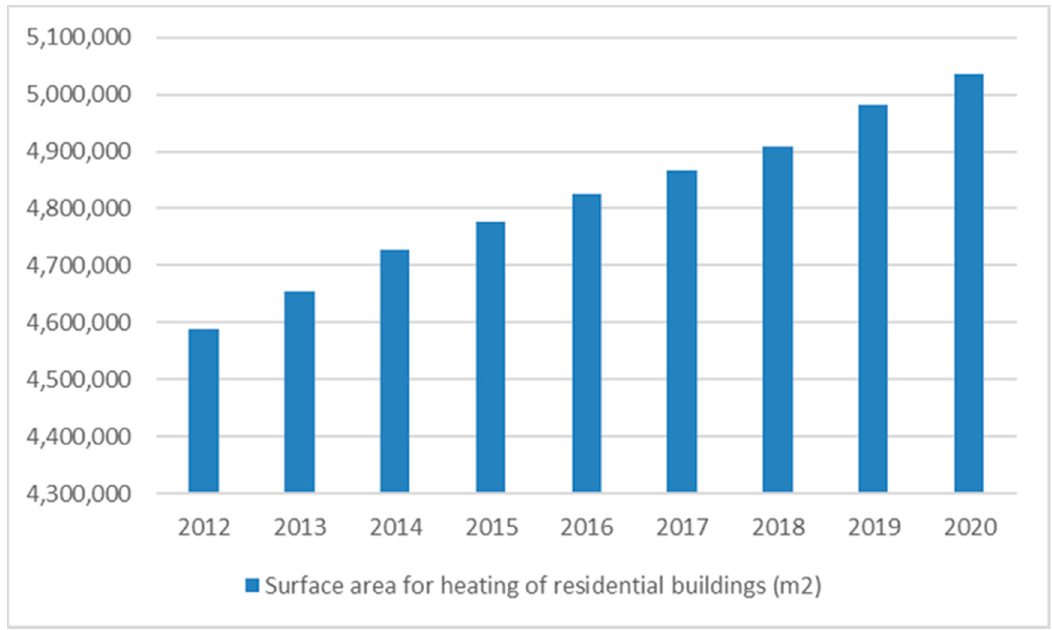
Figure 2. Increase of surface area for heating of residential buildings over the period from 2012 to 2020. From 2012 to 2020, the total residential building surface area for heating connected to the DHS was 447,090 m 2 [38]. The annual growth of the surface area connected to the DHS represents the average European growth of 1%. However, when we look at the annual percentage share of the increase in the surface area for heating since 2014, a decline can be observed, despite the significant increase in new buildings’ construction (Figure 3). The year 2019 shows an increase of newly connected surface area, but already in 2020, there is a decrease compared to 2019.